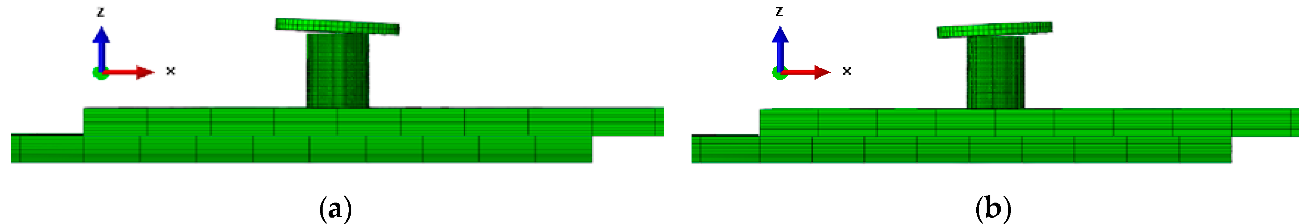
Figure 11. Schematic diagram of the finite element model of different riveting angles and directions: ( a ) 0-3: a pressure riveting model with the punch deflected by 3° under the direction of 0°; ( b ) 180-3: a pressure riveting model with the punch deflected by 3° under the direction of 180°.